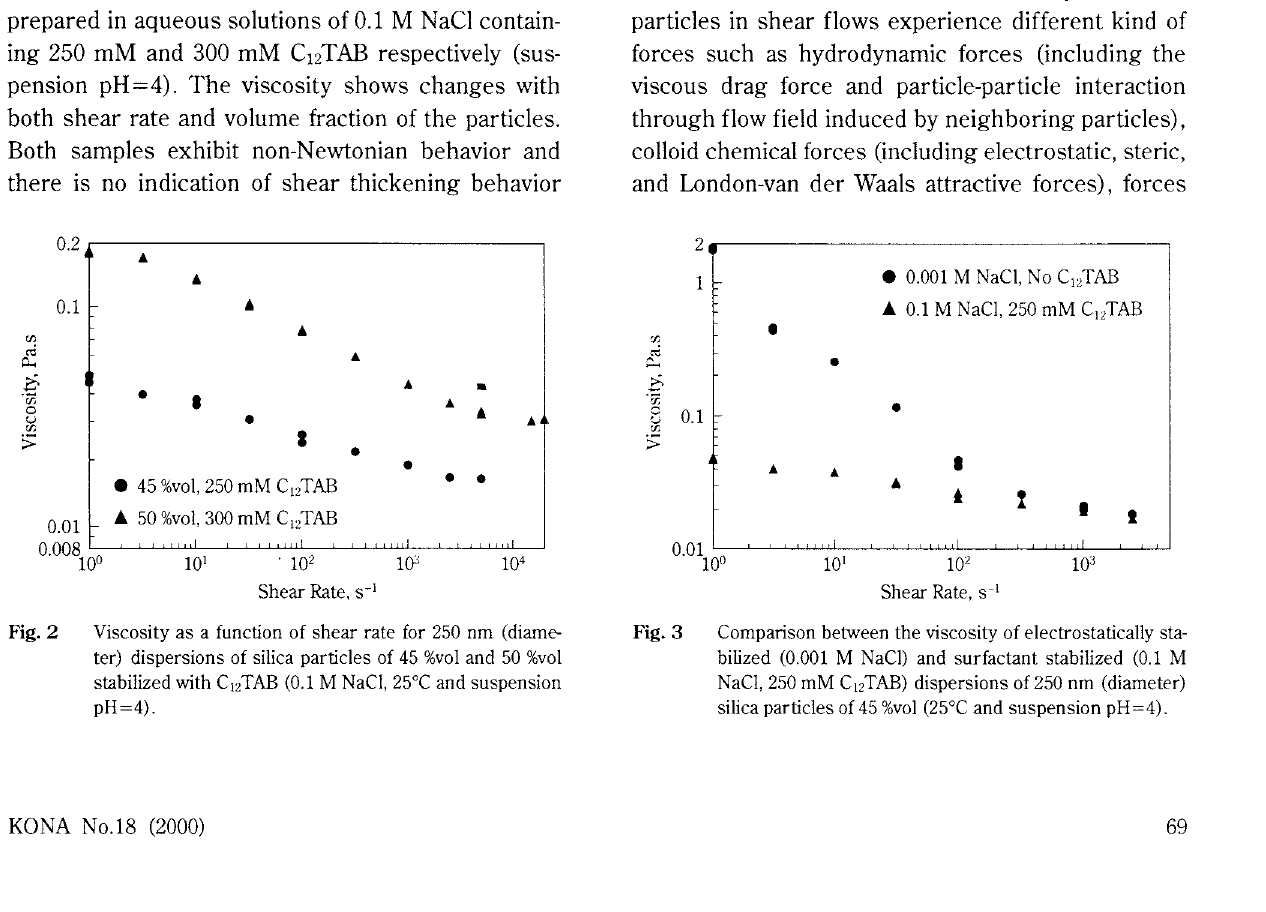
Fig. 2 Viscosity as a function of shear rate for 250 nm (diame ter) dispersions of silica particles of 45 %vol and 50 %vol stabilized with C 12 TAB (0.1 M NaCI, 25oC and suspension pH=4).